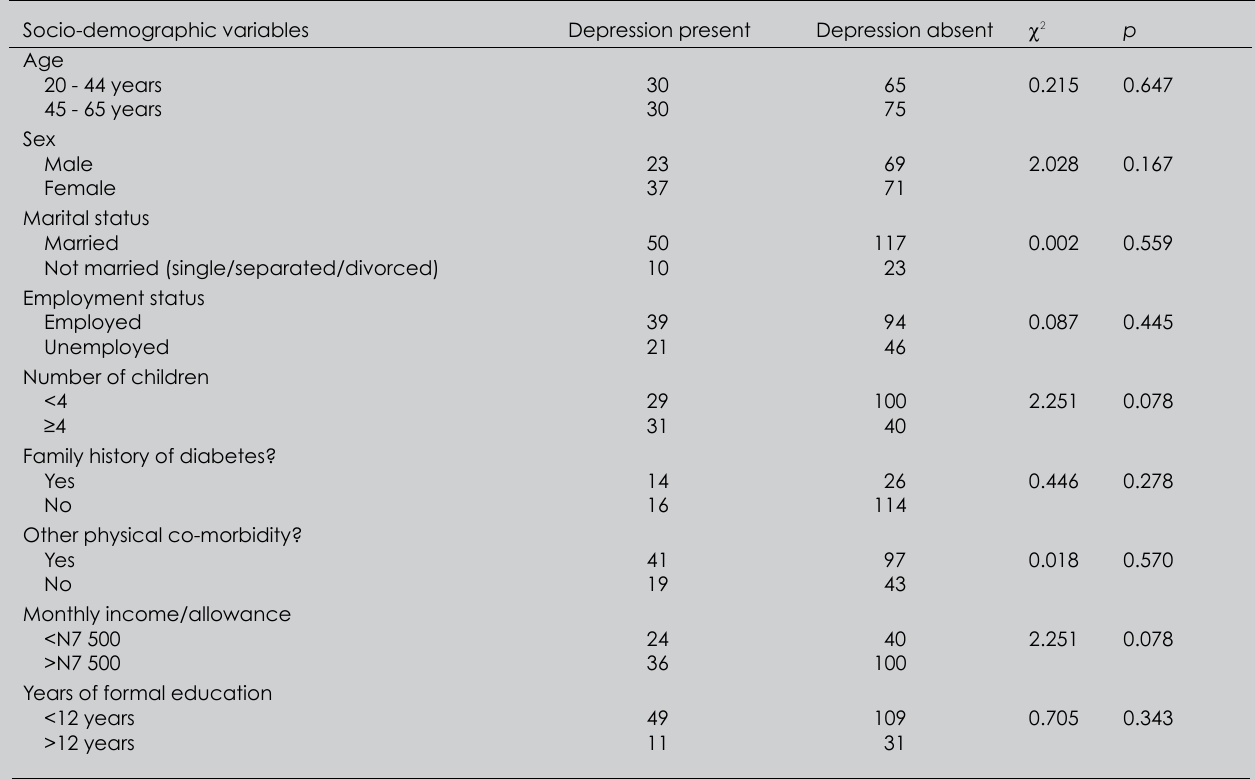
Table I. Comparison of socio-demographic and clinical characteristics of diabetes patients with or without a diagnosis of